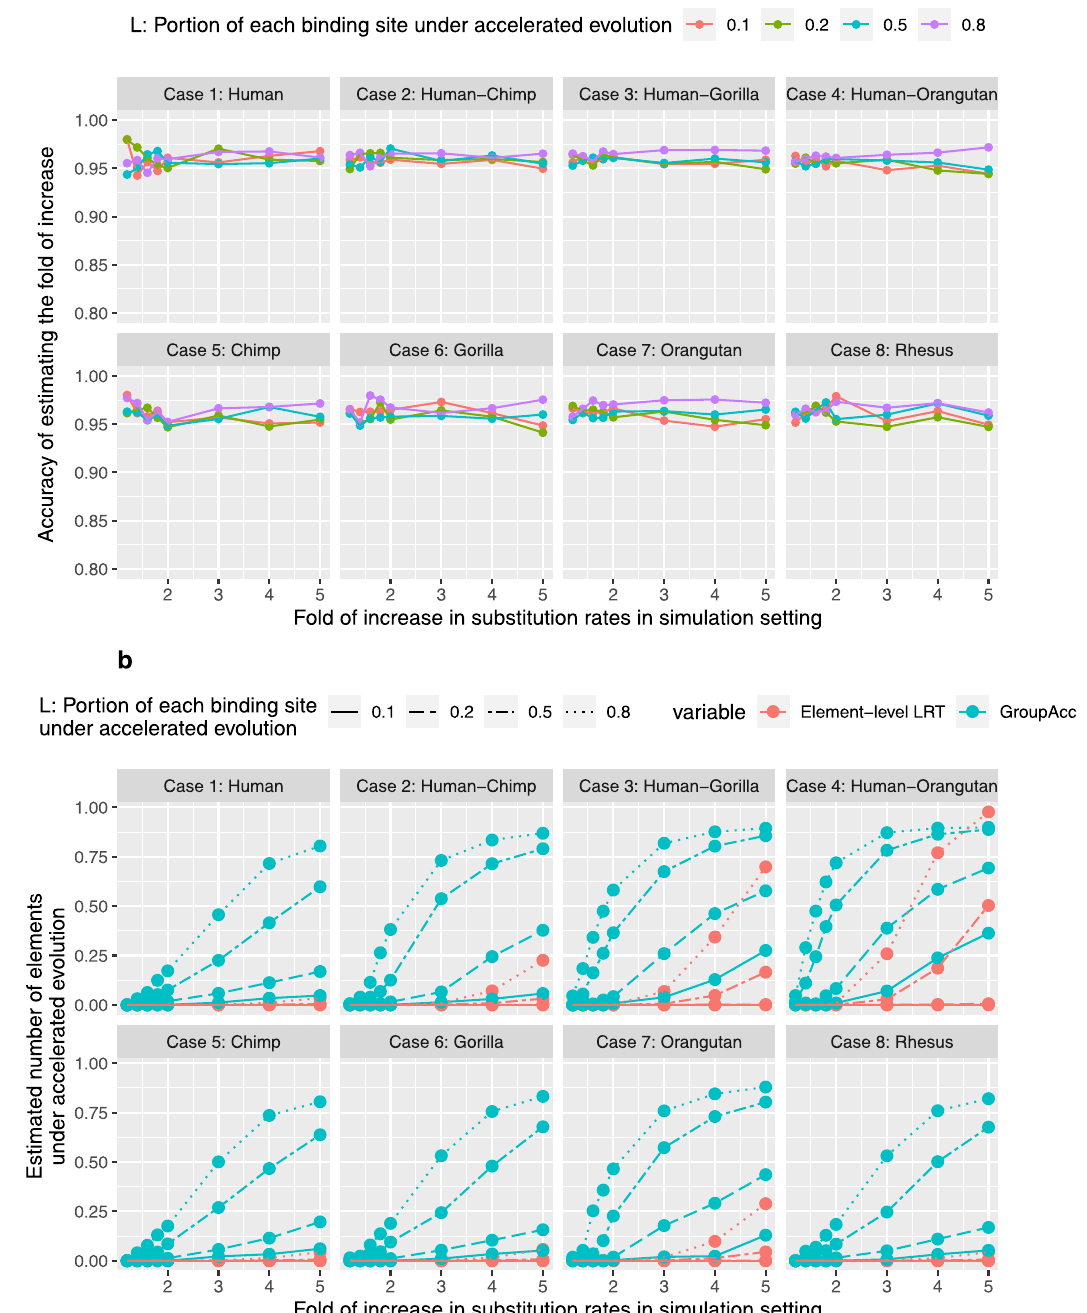
Fig.4|Simulationresultsofscenario2.a AccuracyofGroupAccinestimatingthefoldofincreaseinthesubstitutionrateofforegroundlineagegivendifferentportions ofeachbindingsiteunderacceleratedevolution. X -axisshowsthescalingfactorofacceleratedlineagebranchlengthinsimulationsetting,whichistherealfoldofincrease inthesubstitutionrateofacceleratedlineage.Y-axisshowstheaccuracyofestimatingthefoldofincreaseinthesubstitutionrateoftheacceleratedlineage.Theweighted estimate of the fold of increase in the substitution rate of foreground lineage across the whole group of binding sites is calculated by ( L × ^ r 1 = ^ r 2 +1 (cid:1) L ). The accuracy of estimating the fold of increase is calculated as The weighted estimate of the fold of increase in the substitution rate of foreground lineage r 1 = r 2 in the simulation